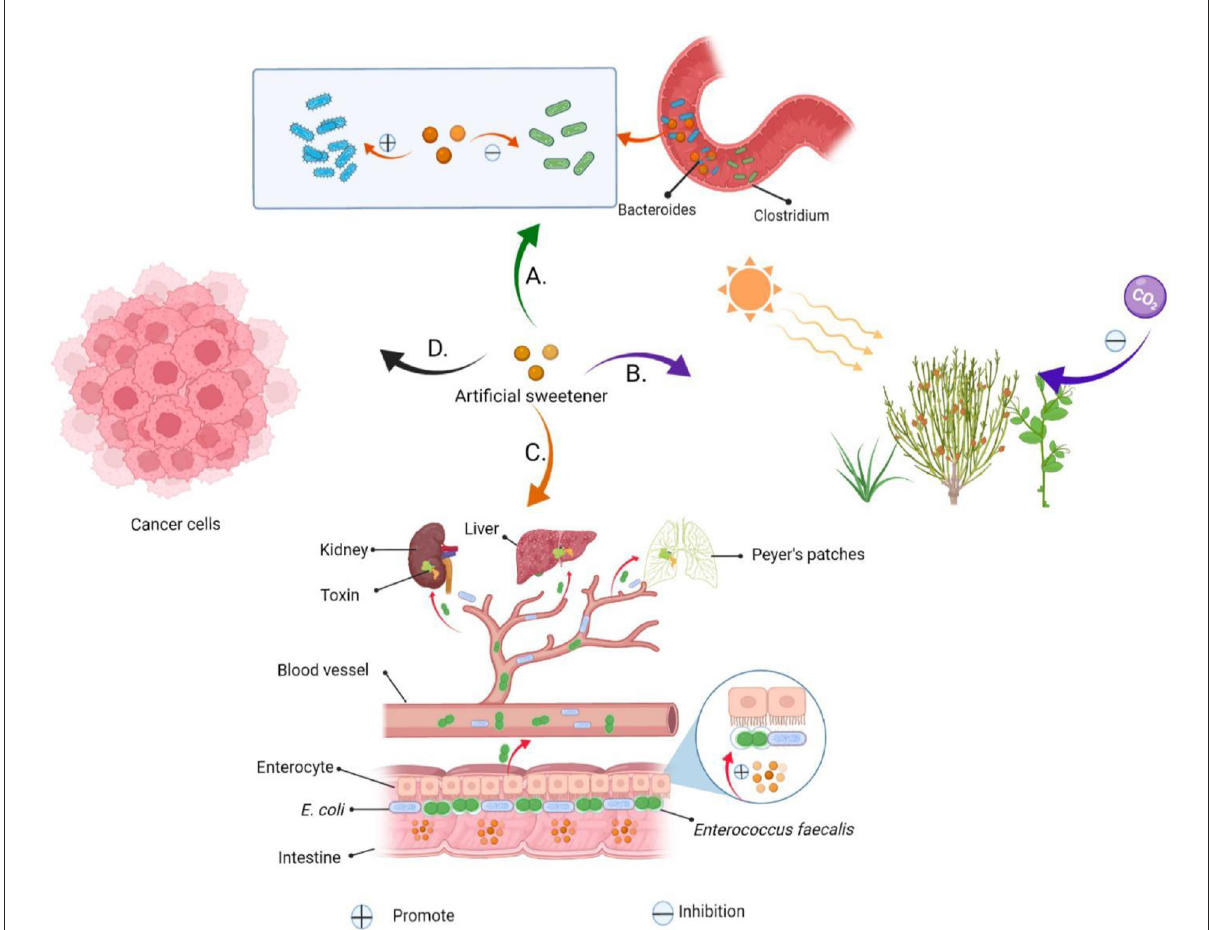
FIGURE2 Artificial sweeteners are harmful to human health and the environment. (A) Artificial sweeteners mediate a reduction in glucose tolerance and insulin resistance by altering the composition of human gut microbes. (B) Environmental hazards caused by artificial sweeteners. (C) Artificial sweeteners can increase biofilm formation in Enterococcus faecalis and E. coli , adhere to and invade the epithelial cells on the intestinal wall, and kill these cells. The sweeteners can easily pass through the intestinal wall, into the blood, and accumulate in the lymph nodes, liver and spleen, thereby causing secretion of some toxins, and predisposing the body to infections, sepsis and multiple organ failure. (D) Artificial sweeteners increase the risk of